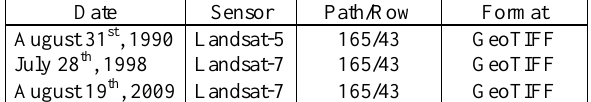
Table 1. Characteristics of the data used in